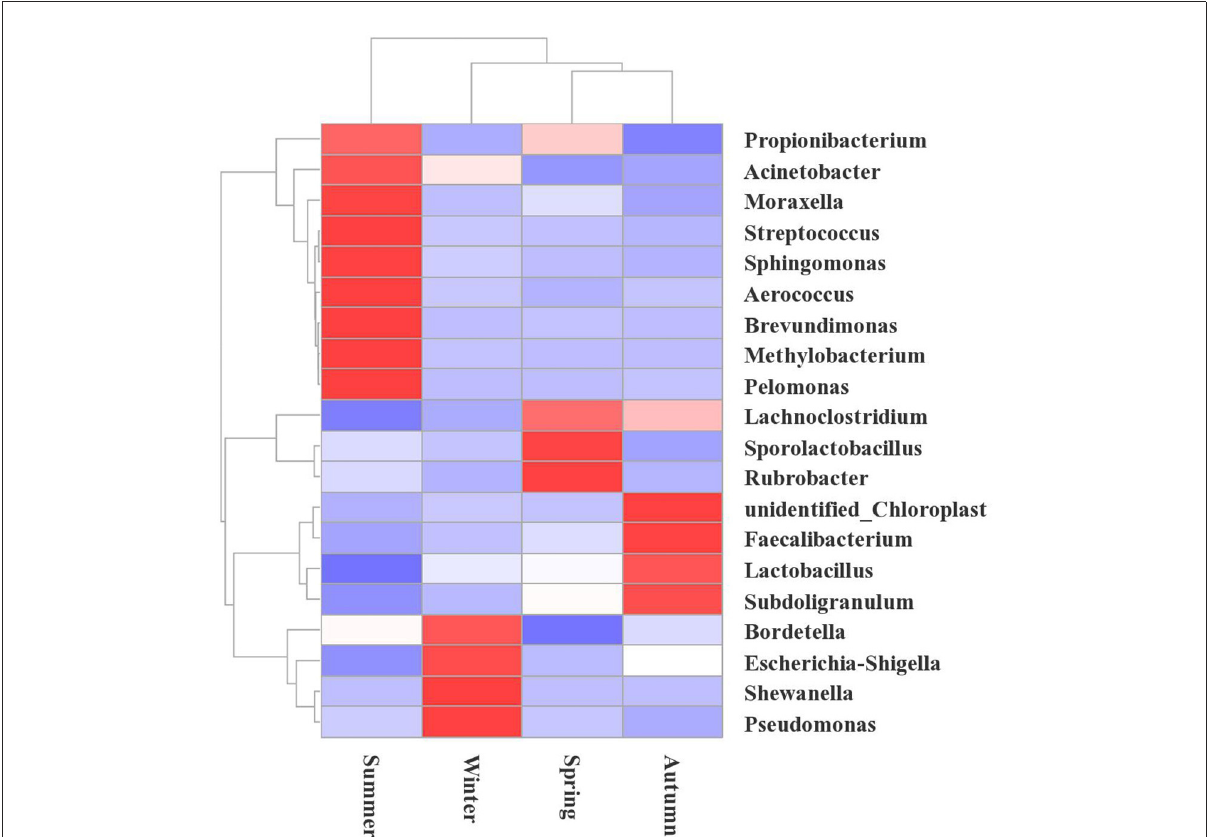
FIGURE5 Heatmap showing the changes in the microbial communities at the genus level during the different seasons in the broiler house. The species cluster tree is shown on the left, and the sample cluster tree is shown on the top. The colors reflect the similarities and differences of the highly rich bacterial community compositions in the broiler house during different seasons. The red gradient indicates higher community richness, and the blue gradient color indicates lower community